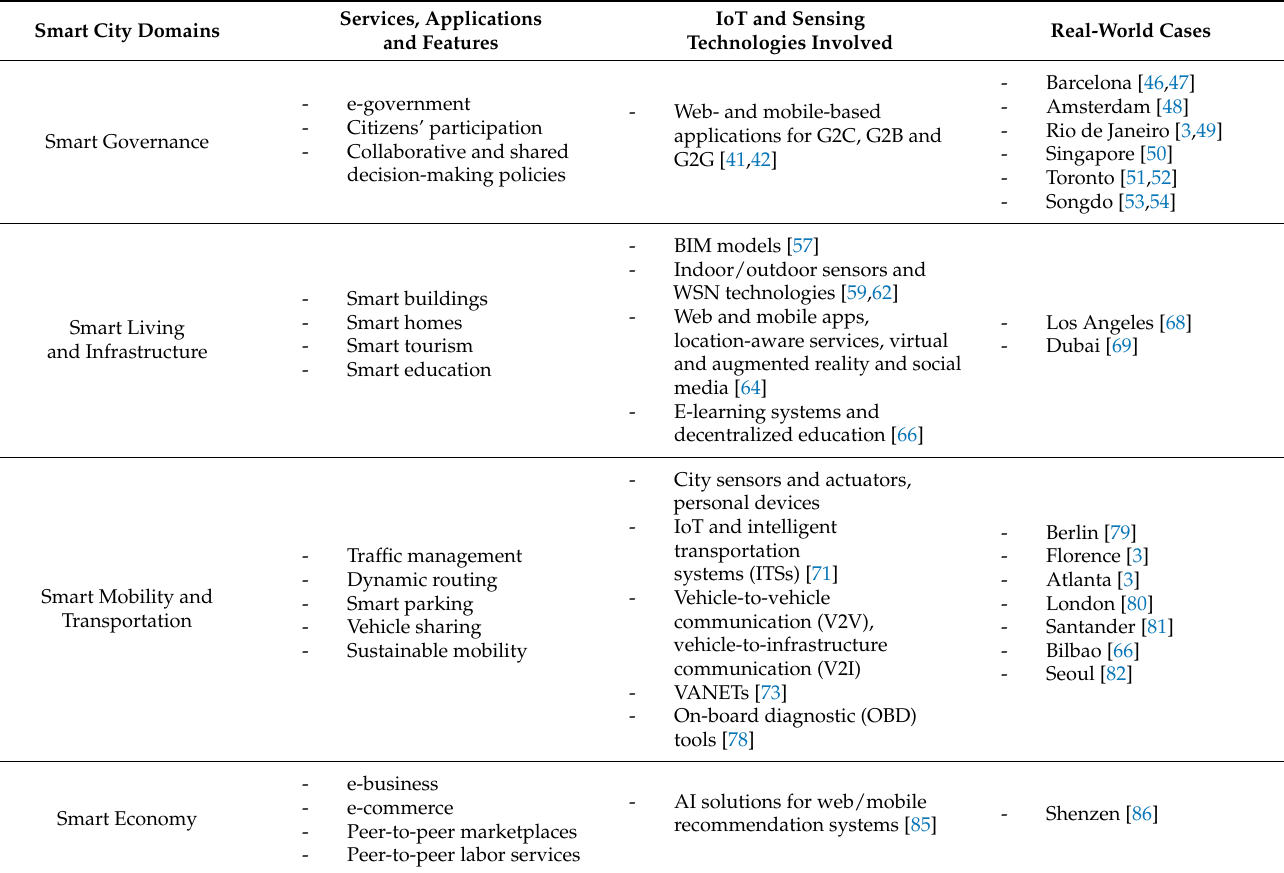
Table 1. A summary of smart city domains: services and features, IoT technologies employed and real-world